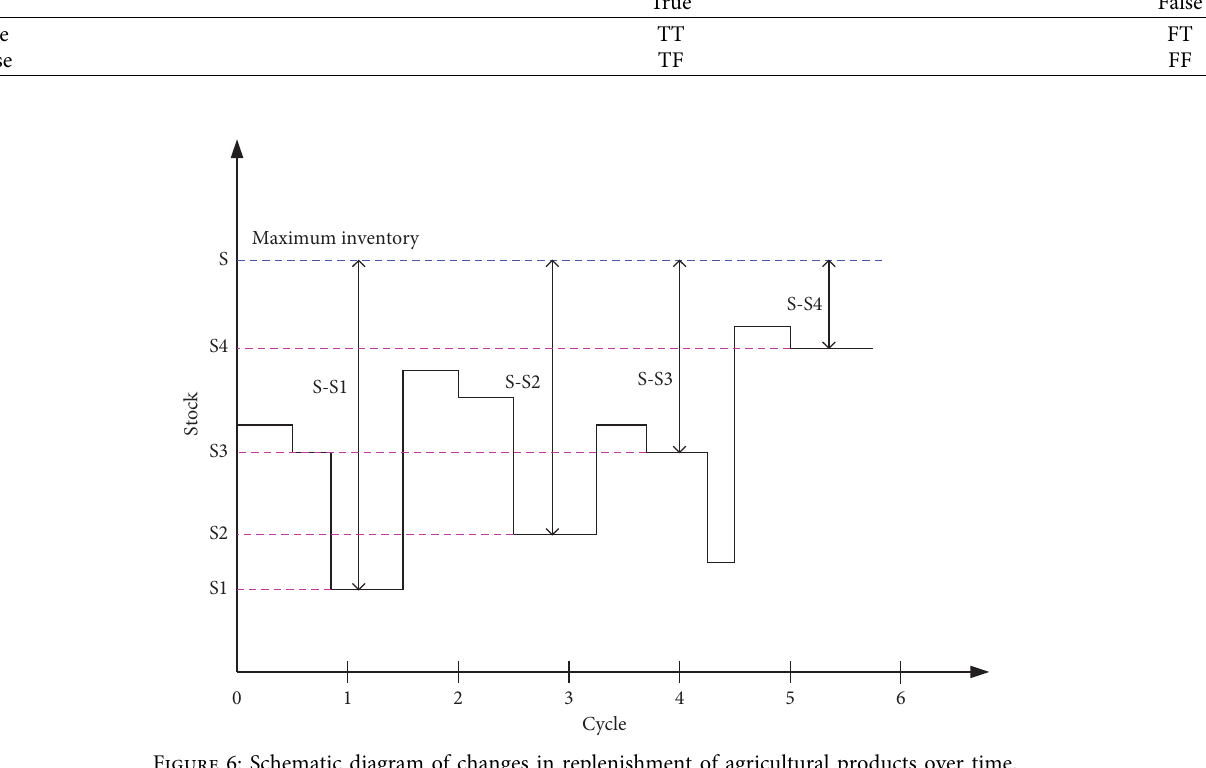
Table 2: The error matrix used to describe the predicted value of the model and the actual statistical value. Actual statistical results